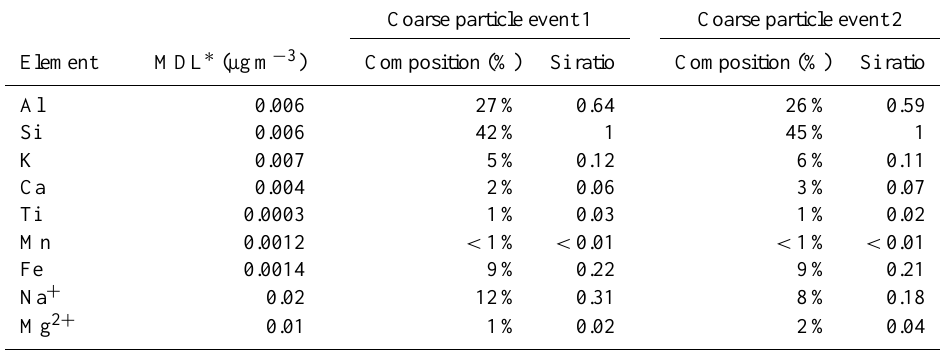
Table 2. Percent composition of mineral species and element 2013 SOAS field